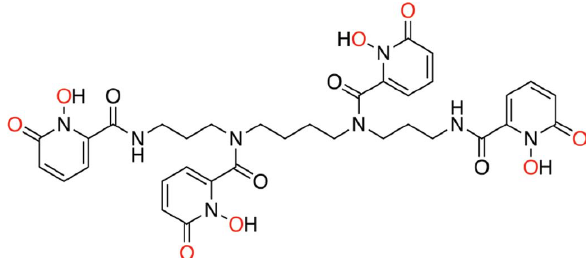
Figure 1 Molecular structure of 343-HOPO. Oxygen atoms expected to bind to the actinide ions are highlighted in red.